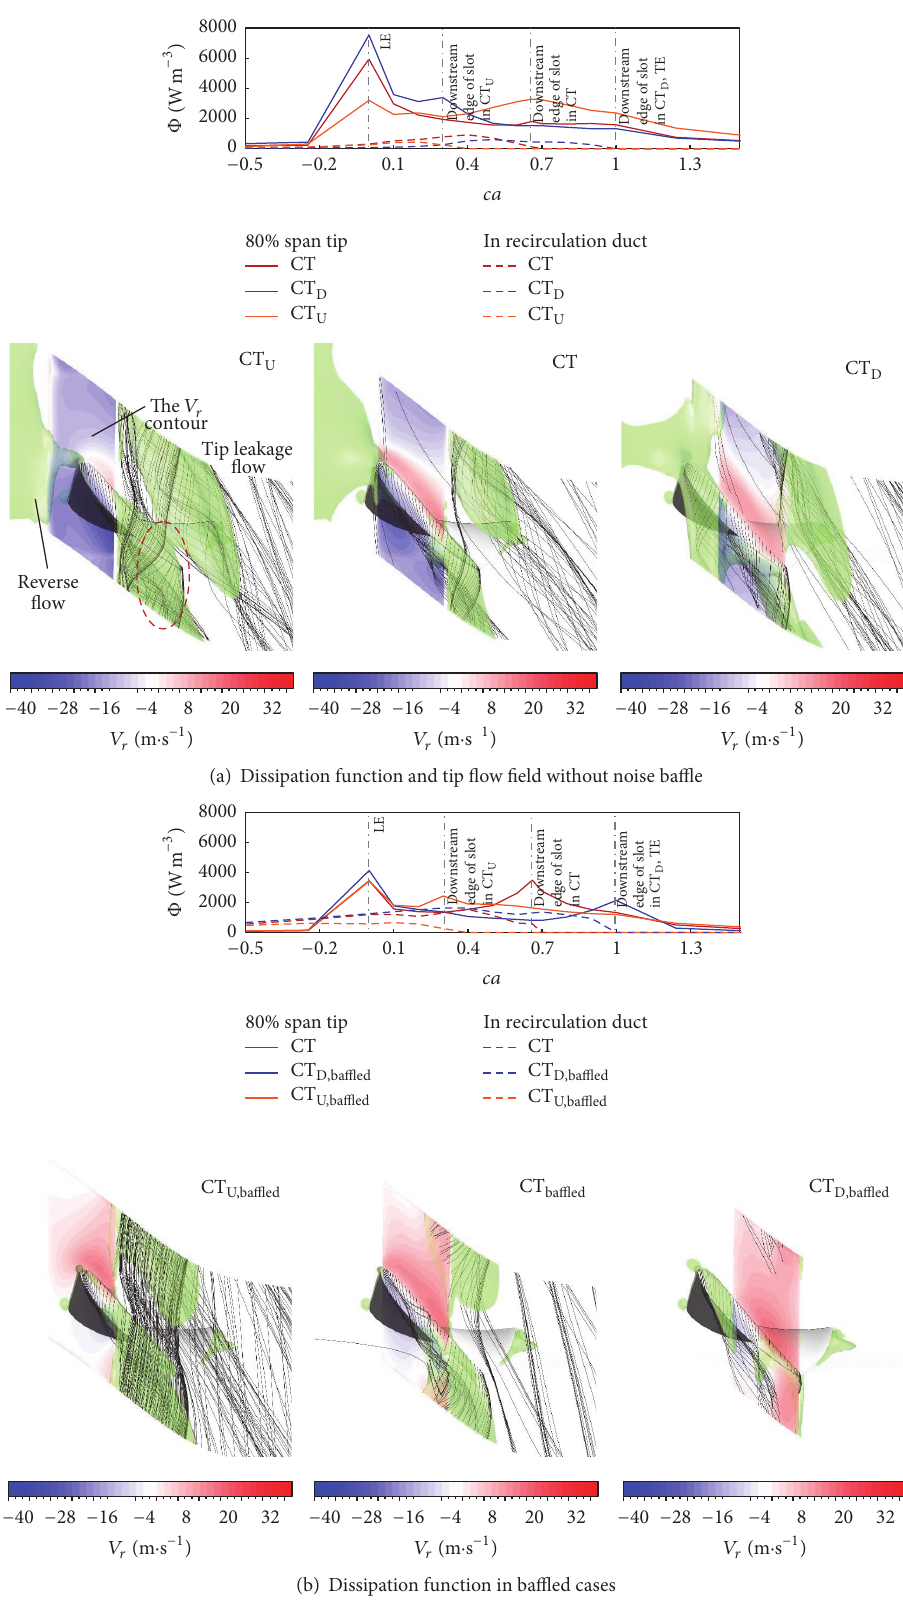
Figure 10: Distribution of loss source in different slot position at 𝑚 = 4.2